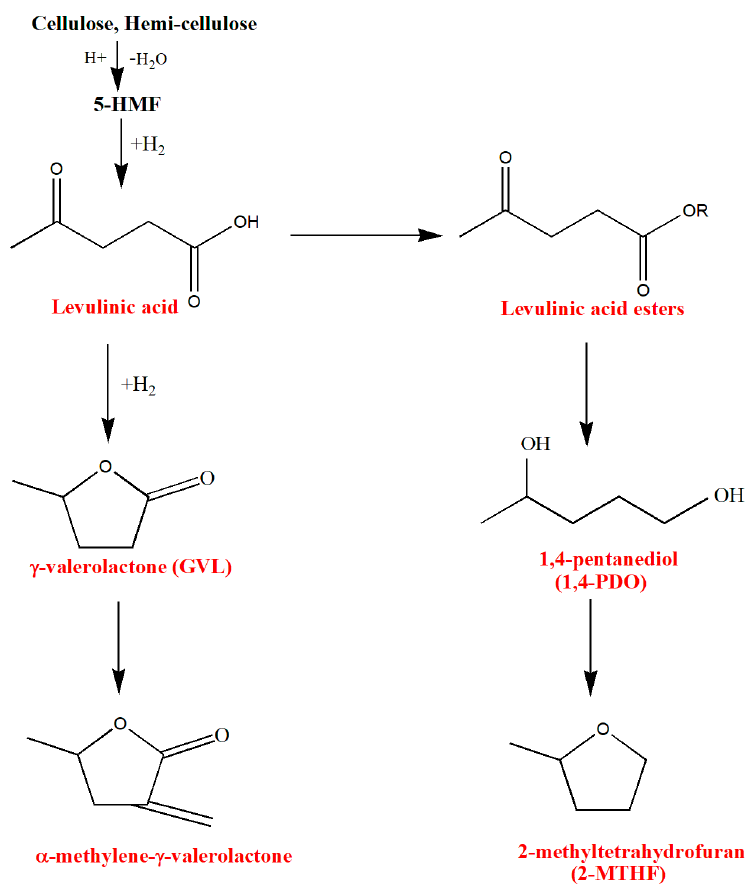
Figure 9. Levulinic acid and derivatives [125–128].